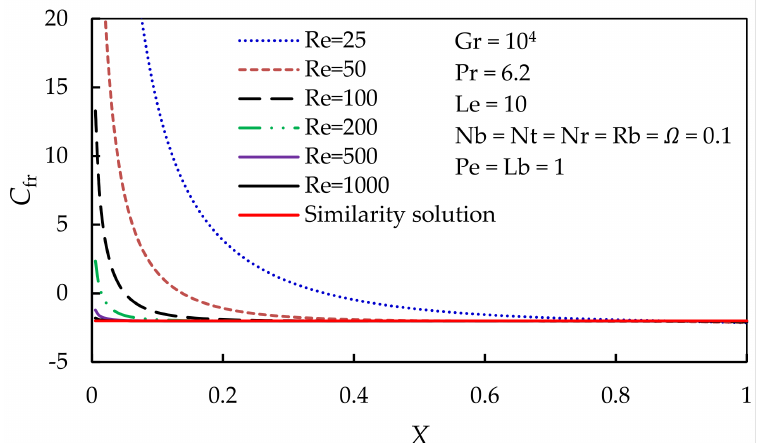
Figure 7. Influence of the Reynolds number, Re , on the reduced skin friction coefficient, C fr , along the sheet surface ( X